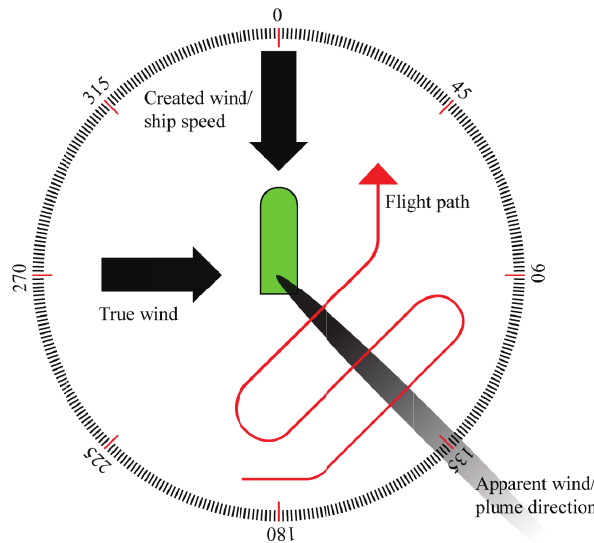
Fig. 4. Illustration of the desired flight path across the plume for the optical measurements. The ship plume points in the direction of the apparent wind which corresponds to the resulting wind of the ship speed and heading and the true wind.